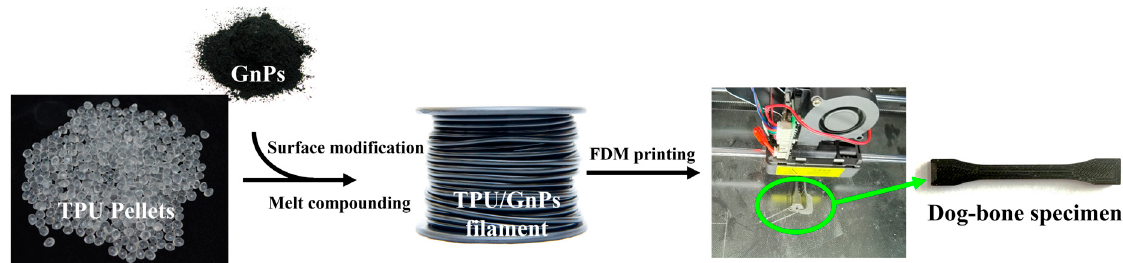
Figure 1. Preparation and FDM printing of specimens.